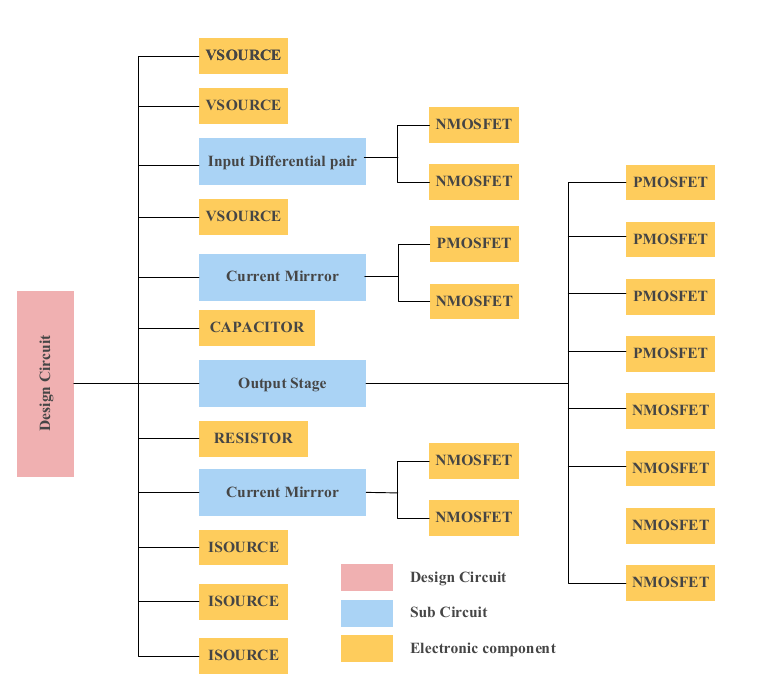
Figure 4. Hierarchical tree.